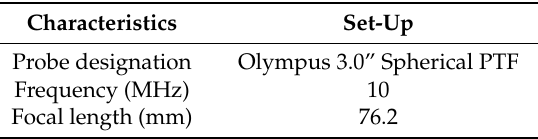
Table 2. C-scan main parameters.